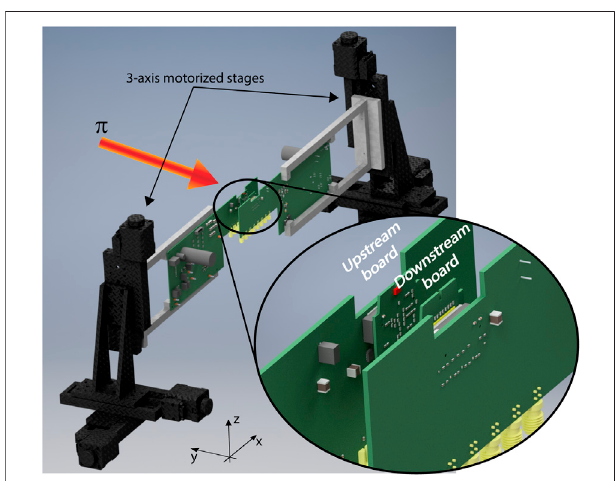
FIGURE 6 | Experimental MIP coincidence measurement